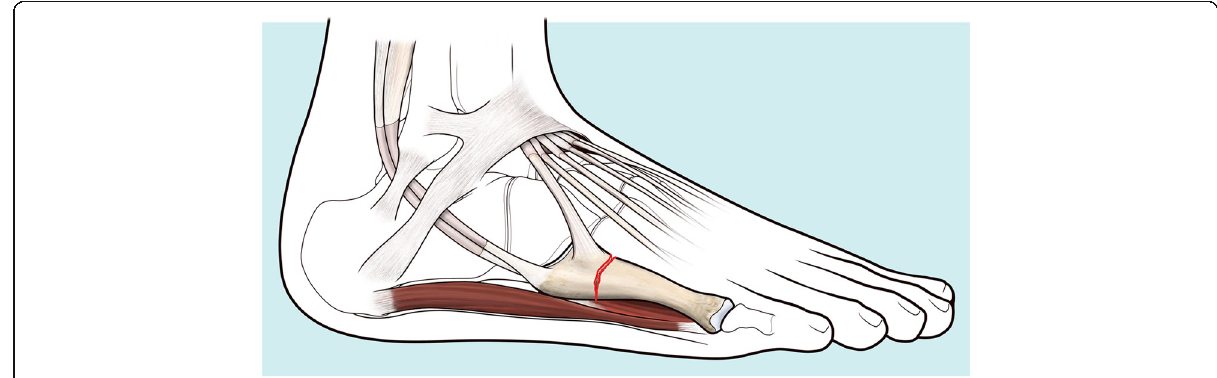
Fig. 1 Proximal fractures or stress fractures of MT-5 (Zone 2 – 3 by Lawrence and Botte) can be treated with the F.E.R.I.